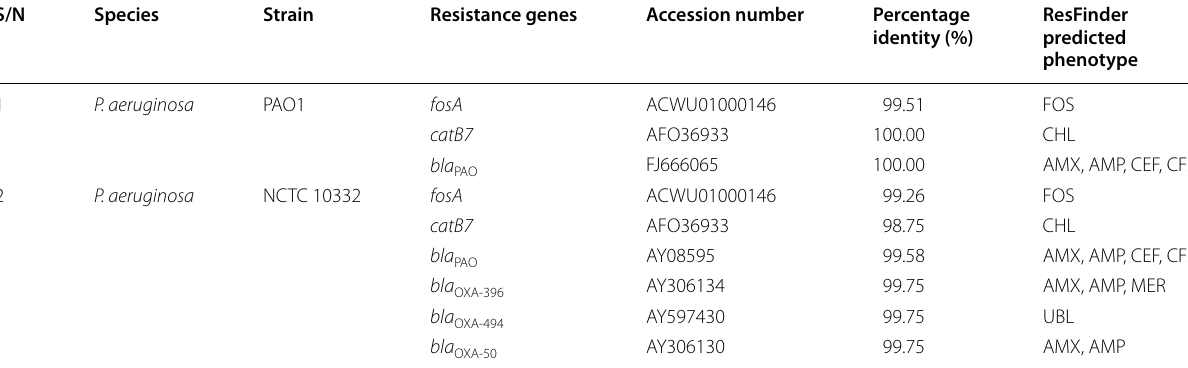
Table 3 ResFinder results for resistance genes of 2 strains of Pseudomonas aeruginosa S/N